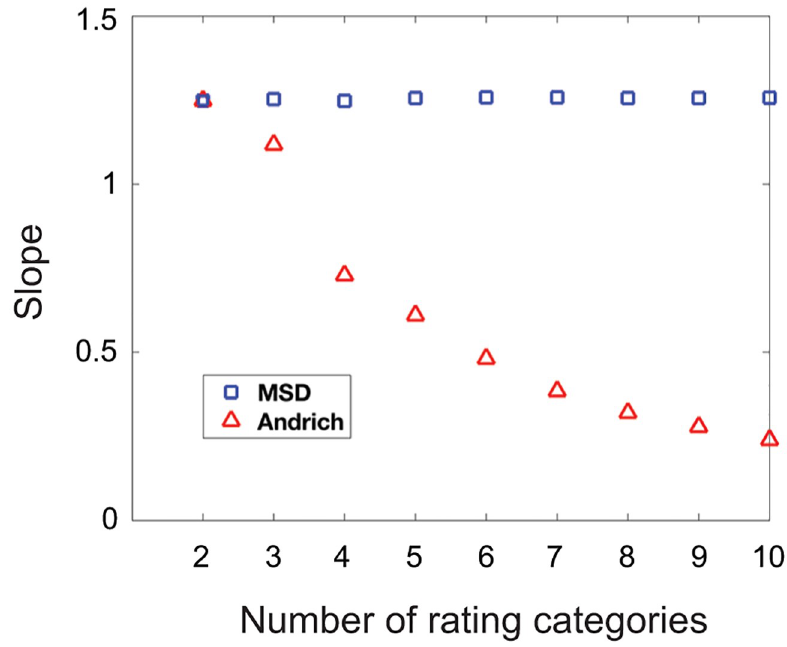
Fig 3. Slopes of the best-fitting line between estimated and true item measures. Slopes of the best-fitting line between estimated and true item measures for MSD (blue squares) and the Andrich model (red triangles) are plotted as a function of the number of rating categories. MSD estimates parameters on the same scale regardless of the number of rating categories because it only uses the dichotomous Rasch model, while the Andrich model estimates parameters on a scale that is dependent on the number of rating categories.